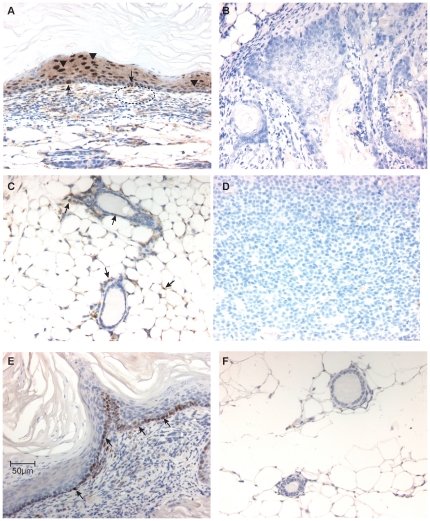

Snai1 and Snai2 are expressed in ATF3-induced tumors.Immunohistochemical analysis of Snail (coded by the Snai1 gene) expression in: A,B, BK5.ATF3 mammary tumors; C, normal mammary gland of a non-transgenic female; D, a mammary tumor from a MMTV.neu transgenic female. In panel B, a blocking peptide specific for Snail was incubated with the anti-Snail antibody as a negative control. Arrows, labeled basal cell nuclei; arrowheads, labeled supra-basal cell nuclei. Immunohistochemical analysis of Slug (coded by the Snai2 gene) in E, a BK5.ATF3 mammary tumor and F, an apparently normal mammary gland from a tumor-bearing BK5.ATF3 female. Scale bar in E = 50 µm, applies to all panels.